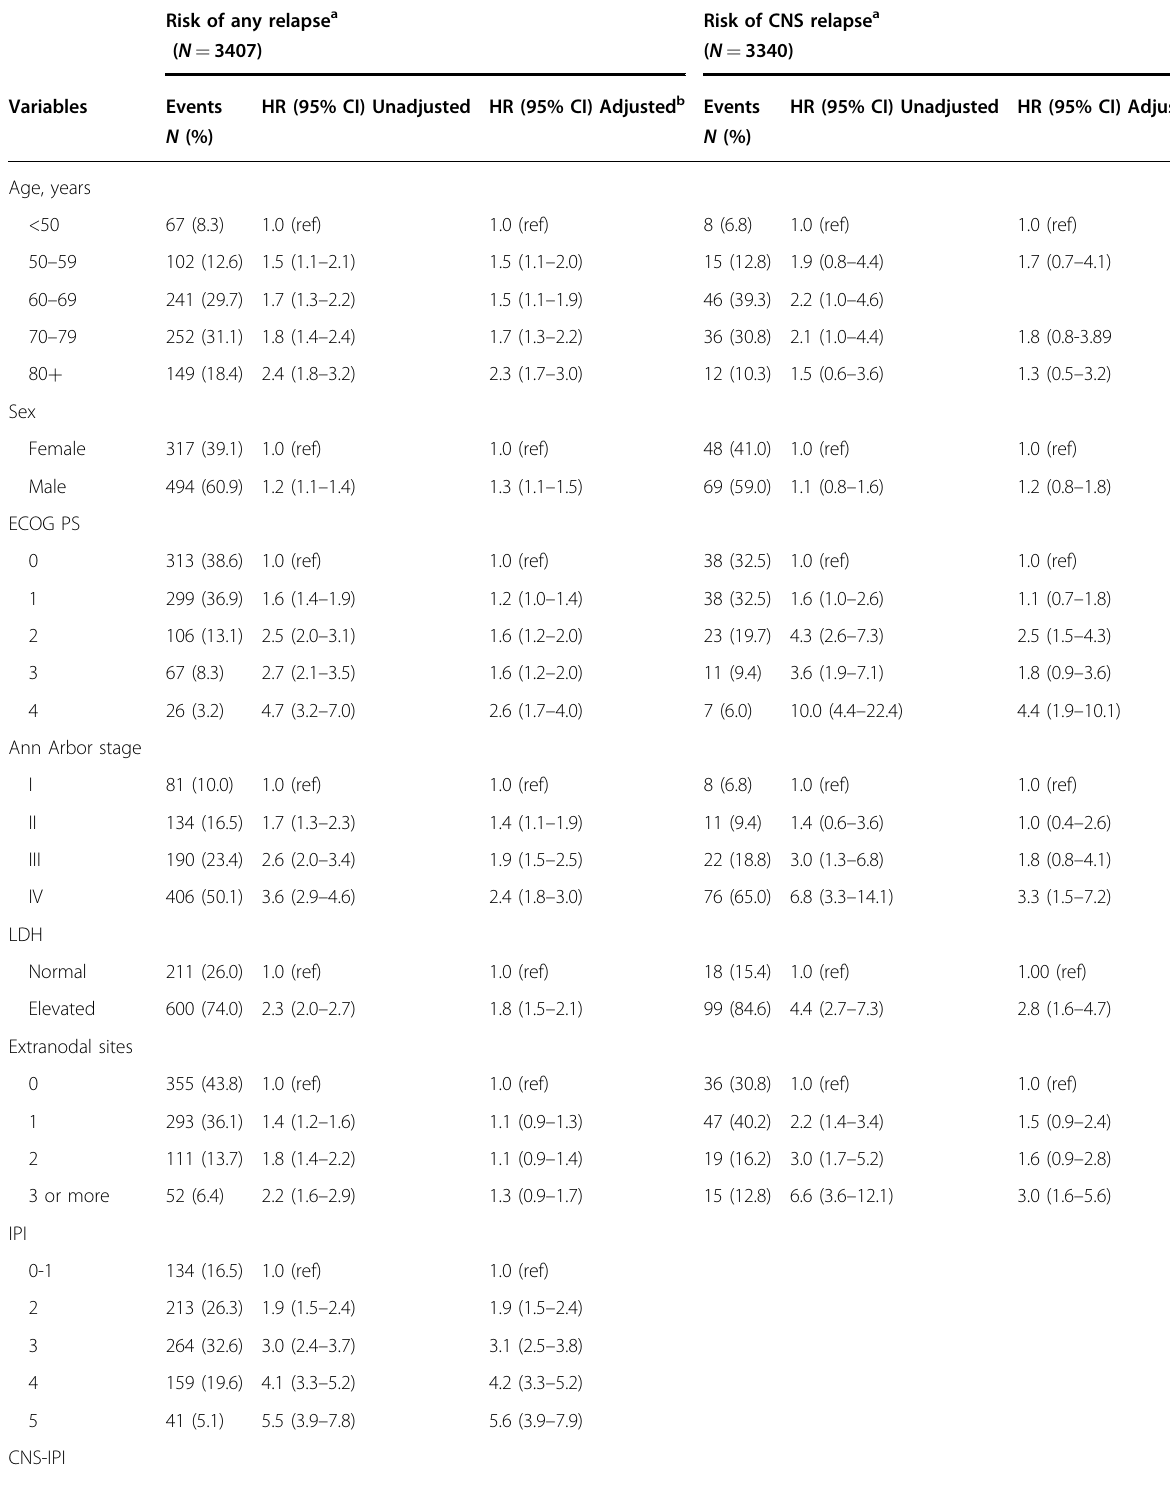
Table 3 Clinical characteristics and relative risk (hazard ratios (HR) with 95% con fi dence intervals (CI)) of relapsed/ refractory disease at any site or in the CNS among curatively treated diffuse large B-cell lymphoma (DLBCL) patients diagnosed 2007 – 2014 in